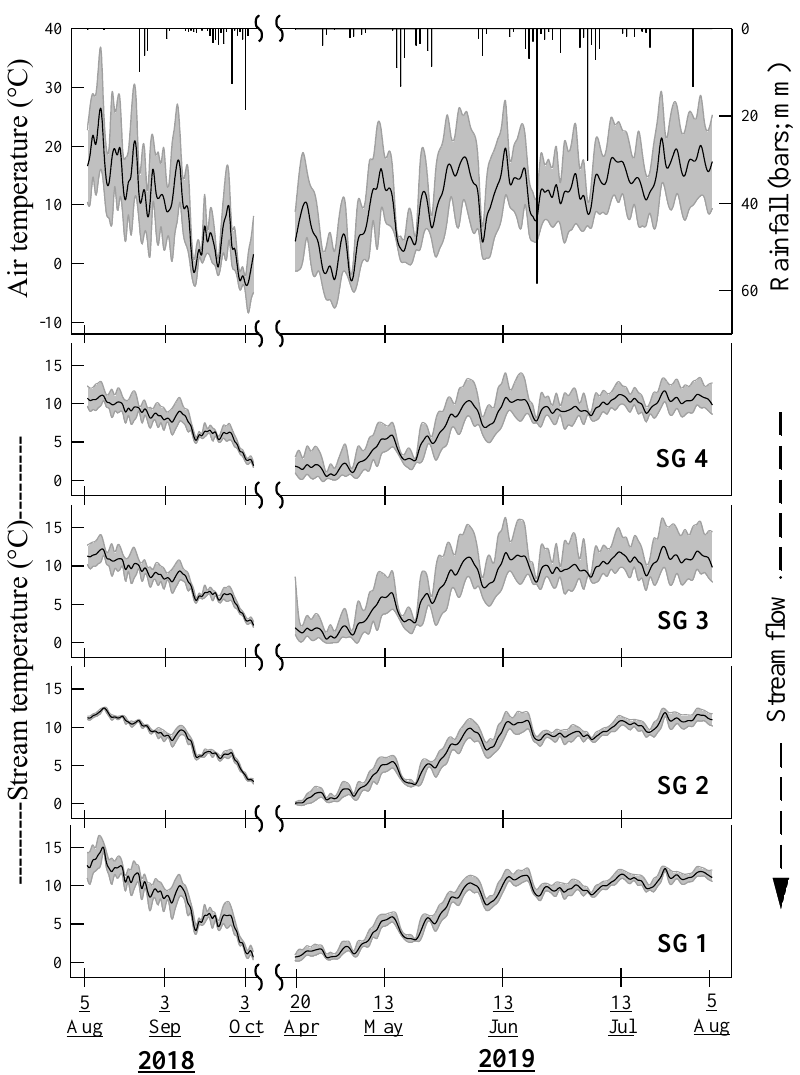
Figure 3. Daily ambient air temperature range (black line is mean, grey area is range) and hyetograph (top panel), and daily stream thermographs at SG4-SG1 (bottom four panels) across the pine creek study reach for the post-BDA installation period (2018–2019).